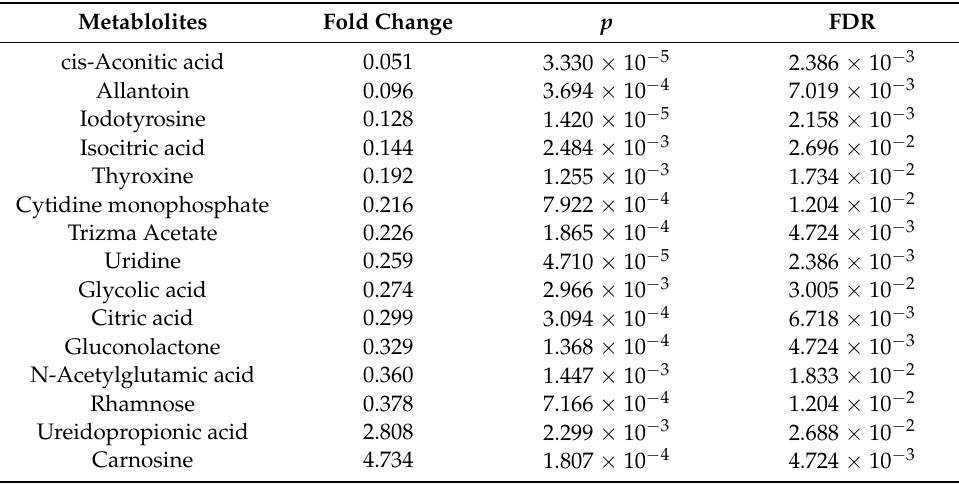
Table 2. List of the altered metabolites identified in comparison between TN0 and PN0.